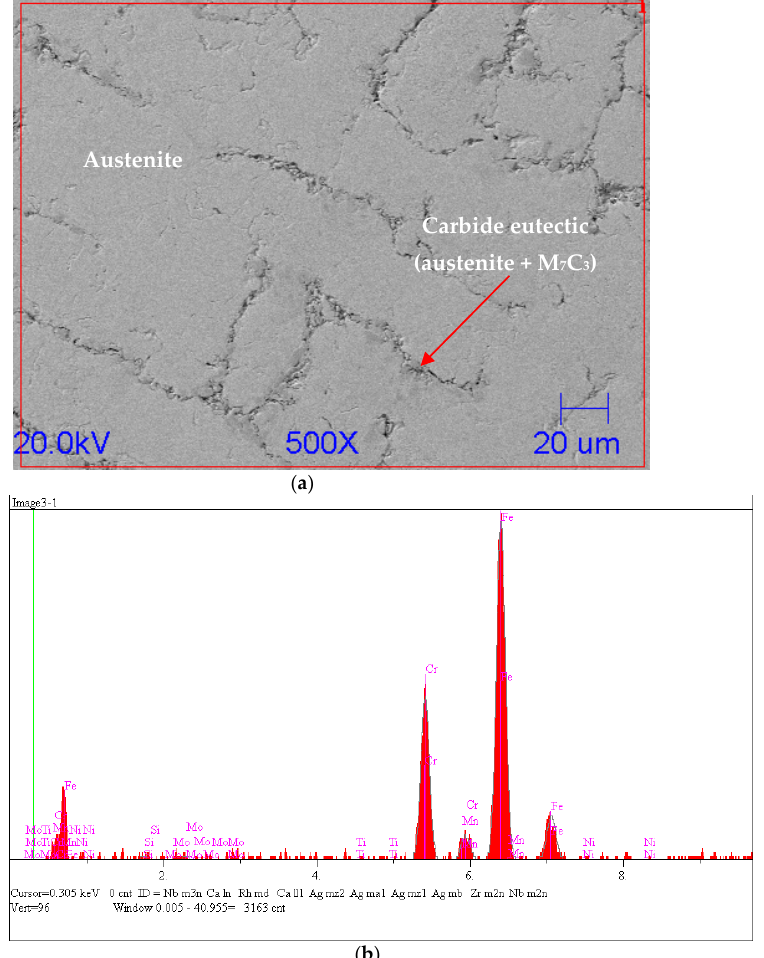
Figure 10. ( a ) Scanning microscope analysis of reference sample; ( b ) qualitative EDS analysis from area.